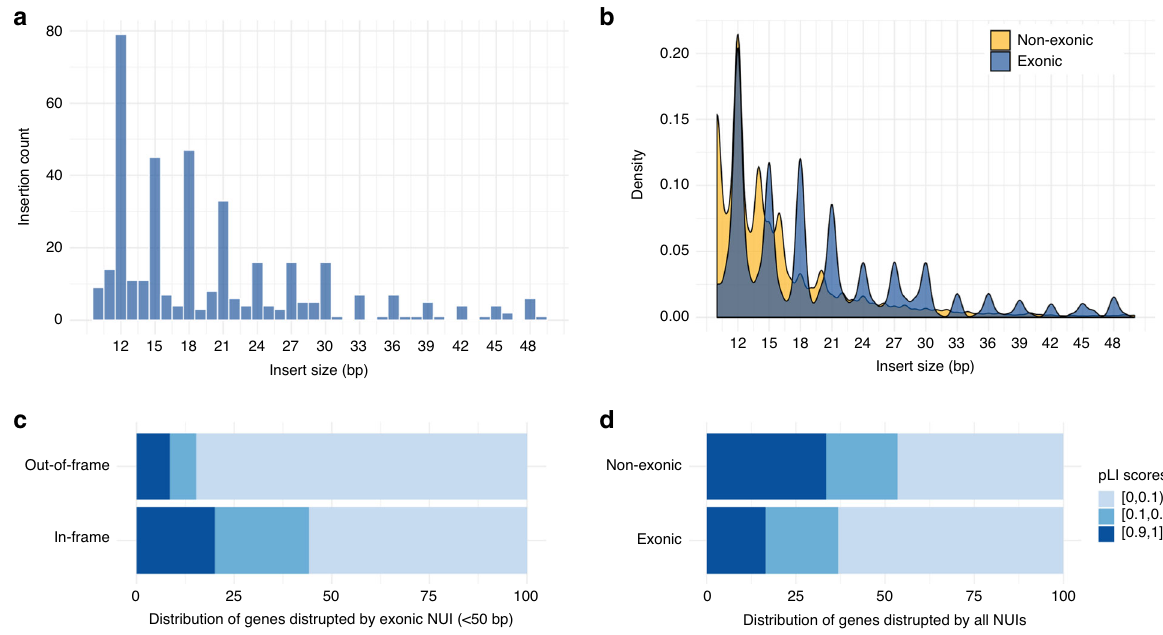
Fig. 2 Evolutionary constraints on exonic NUIs. a Histogram of small NUIs (<50 bp) disrupting exons. The 3 bp periodic trend shows that the majority of these events are in-frame, suggesting that that a strong evolutionary constraint is in place to preserve the structural and functional integrities of the proteins. b Density plot comparing the 3 bp periodic trend in exonic (blue) versus non-exonic (yellow) NUIs. c Horizontal barplot showing the pLI scores distributions of genes whose exons are disrupted by in-frame or out-of-frame small NUIs. d As in c but exonic and non-exonic NUIs of all size ranges are